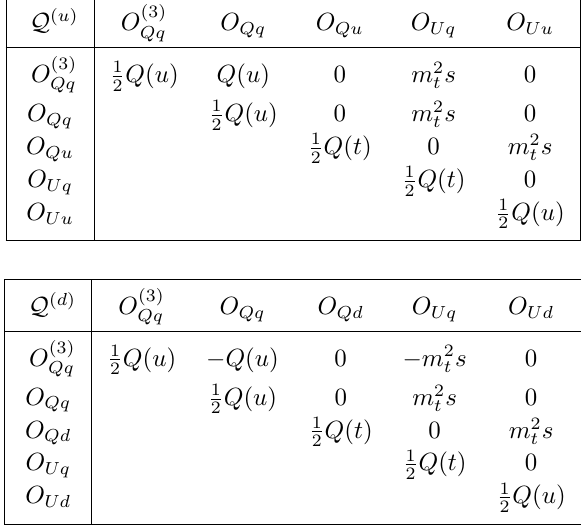
Table 2 . Quadratic terms contributing to the squared matrix element for q (cid:22) q ! t (cid:22) t , parametrized as in eq. (A.2), for the color octet operators listed in table 1. Here Q ( x ) = ( x=m 2 are symmetric and lower diagonal elements are not